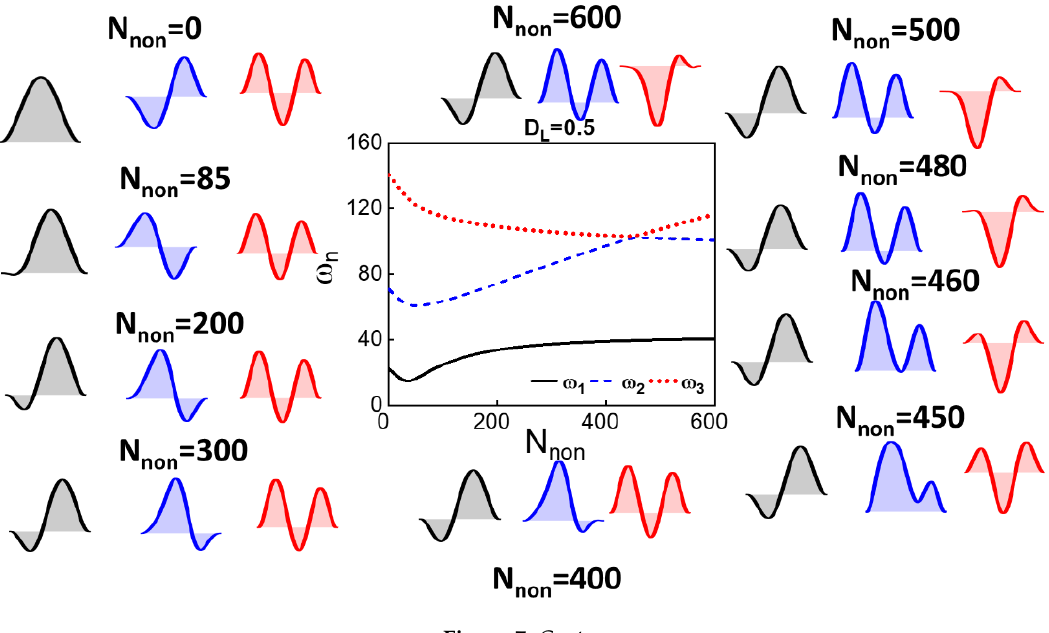
Figure 7. Cont ( a )